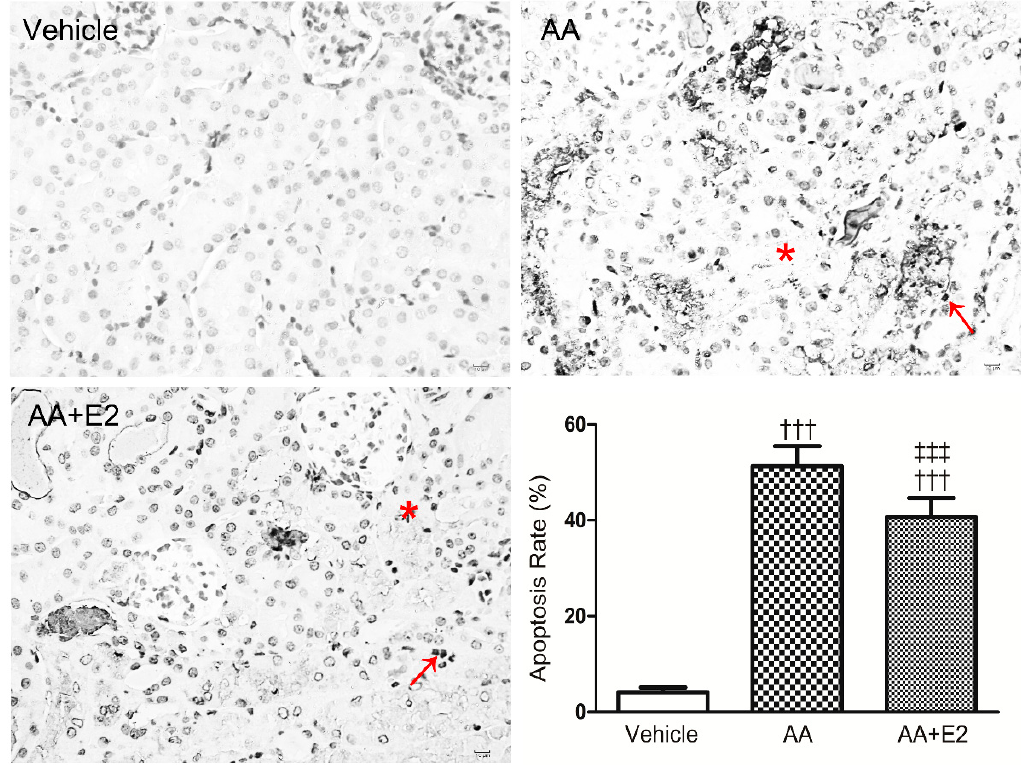
Figure 5. AA-induced RTEC apoptosis (showed by TUNEL-stained sections and quantitative analysis of TUNEL + apoptotic cells) in male mice at day 5 were alleviated by treatment with E2. Note that there were many TUNEL + apoptotic cells (arrow) in the area with cortical tubular necrosis (asterisk) in a male AAN mouse with or without E2 treatment. Data were expressed as means ± SD for groups of 6 mice. ††† p < 0.001 vs. vehicle group; ‡‡‡ p < 0.001 vs. AA group. Magnification, ×200.